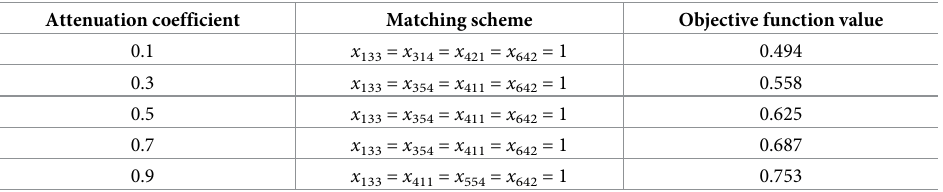
Table 7. Parameter analysis of objective